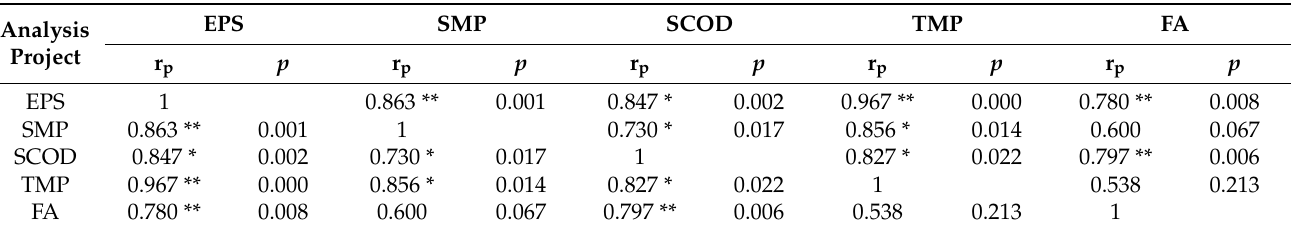
Table 3. Correlation between